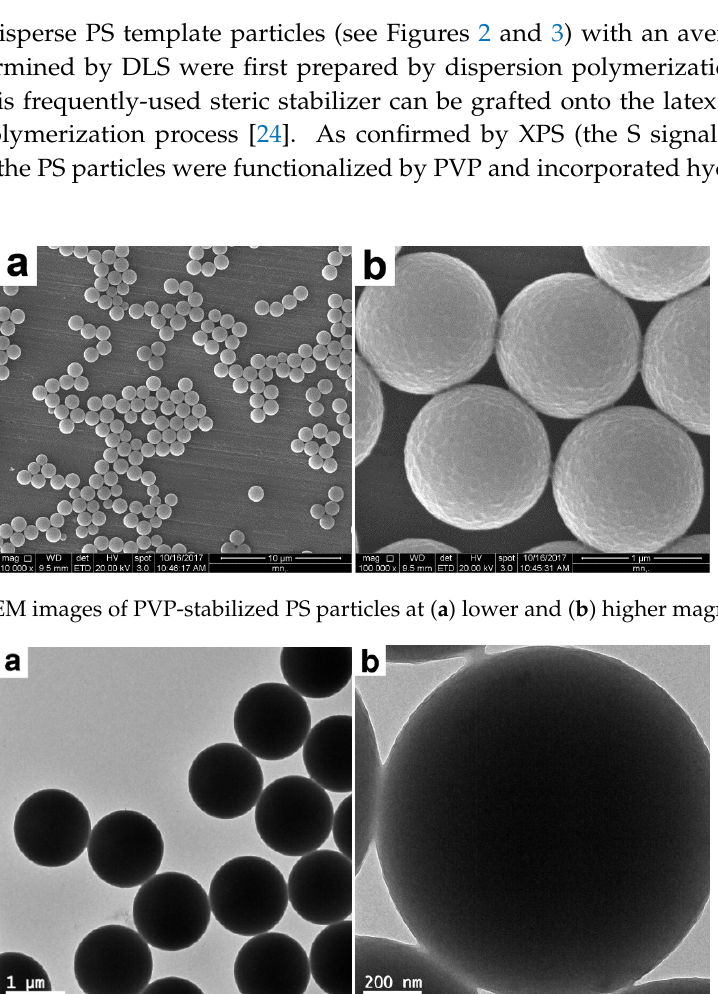
Figure 3. TEM images of PVP-stabilized PS particles at ( a ) lower and ( b ) higher magnifications.